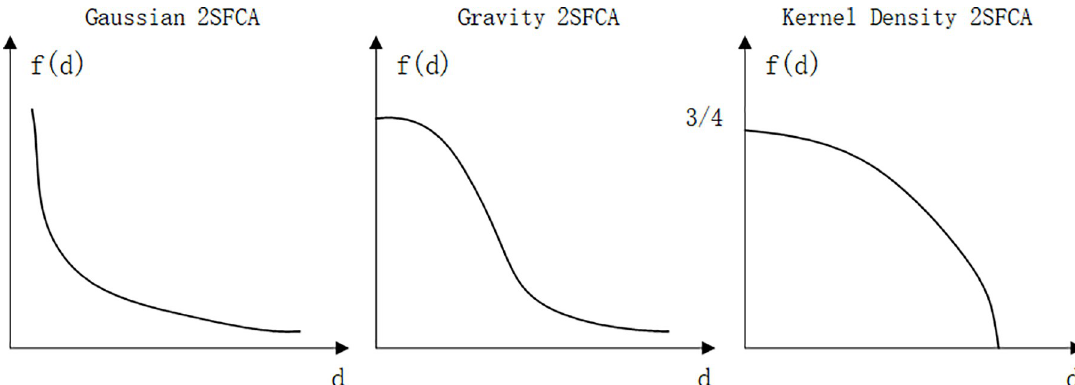
Fig 6. Diagram of distance decay function. (Self-drawn by the